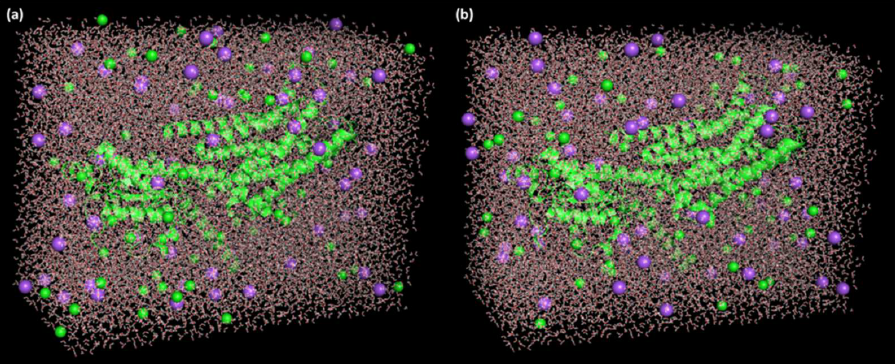
Figure 2. Receptor–ligand complex ( a ) SRXD and ( b ) CTcD in triclinic box solvated with water molecules and neutralized with 59 Na + and 64 Cl − ions (0.15 M salt).